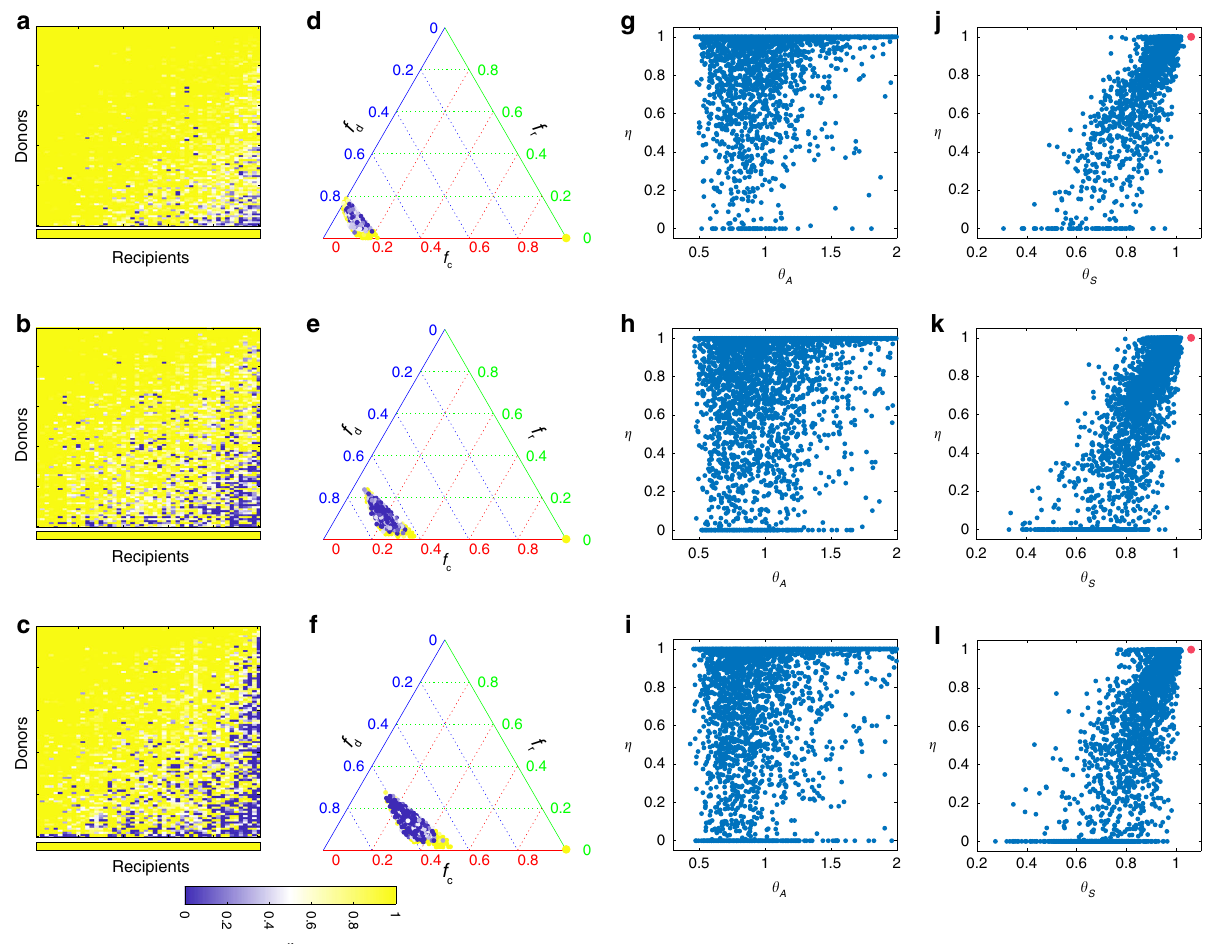
Fig. 5 Impact of donor − recipient compatibility on FMT ef fi cacy. We simulate the FMT processes with universal microbial dynamics. Species in the gut microbiota of 100 healthy donors are randomly chosen from a pool of 100 species with the only condition that C. dif fi cile cannot colonize. The resulting healthy microbiota of those 100 donors contains 60 − 80 species. From top to bottom, the pre-FMT microbiota of 50 recipients contain 10 − 15 (top), 20 − 25 (middle), and 30 − 35 (bottom) species, respectively. a – c We simulate the FMT process for each of the 100 × 50 (donor, recipient) pairs, and plot the recovery degree in a 100 × 50 matrix, where rows (or columns) are sorted based on the average recovery degree of each row (or column). The bottom row represents the recovery degree of autologous FMT, i.e., transplanting the recipient ’ s own initially healthy microbiota back to his/her disrupted microbiota. d – f Recovery degrees of the 100 × 50 (donor, recipient) pairs in the ternary plot of fractions of donor-speci fi c taxa ( f d ), recipient-speci fi c taxa ( f r ), and common taxa ( f c ). The color of each point represents the recovery degree of the FMT associated with the corresponding (donor, recipient) pair. The f bottom right yellow point indicates the recovery degree of autologous FMT (with f c = 1, f 0). g – i Scatter plot of the recovery degree η and the direct P P d ¼ r ¼ N N a (cid:2) = a þ a (cid:2) a a þ a j on C. interaction strength ratio θ A ¼ Cj < 0 ( Cj > 0) means direct inhibition (promotion) effect of species- P P j ¼ 1 ; j ≠ C j j ¼ 1 ; j ≠ C Cj j Cj for Cj . Here, Cj for N N dif fi cile . j – l Scatter plot of the recovery degree η and the net or effective interaction strength ratio θ s (cid:2) = s þ s (cid:2) s s þ S ¼ Cj < 0 ( j ¼ 1 ; j ≠ C j j ¼ 1 ; j ≠ C Cj j Cj for Cj . Here, Cj for s j on C. dif fi cile . Red point indicates that in the post-FMT microbiota C. dif fi cile Cj > 0) means net or effective inhibition (promotion) effect of species- becomes extinct, for which θ S is unde fi ned but the recovery degree η = 1. See Supplementary Note 1 for details on the model parameters used in the FMT